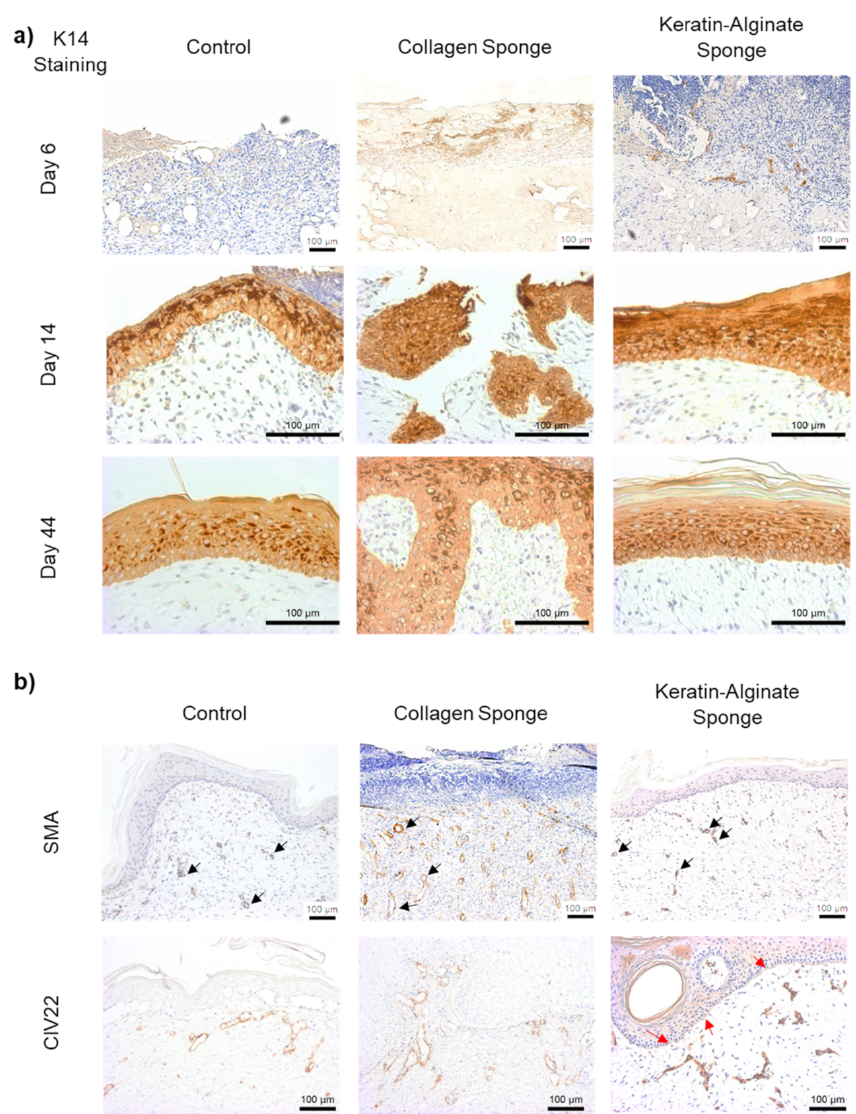
Figure 6. Immunohistochemical staining of wound biopsies. ( a ) Keratin 14 (K14) expression in the sample groups on days 6, 14, and 44. K14 was not found on day 6 due to the debridement of damaged tissue done on day 2 but was expressed at days 14 and 44 as the epidermis regenerates. ( b ) Alpha-smooth muscle actin (SMA) and collagen IV (CIV22) expression in day 44 wounds. Alpha- smooth muscle actin was present in all three groups (black arrows). Collagen IV staining indicate the presence of a mature basement membrane at the epidermal–dermal junction in the keratin–alginate sponge grafted wounds (red arrows), which is not significant in the control and collagen sponge grafted wounds (Scale bar: 100 µ